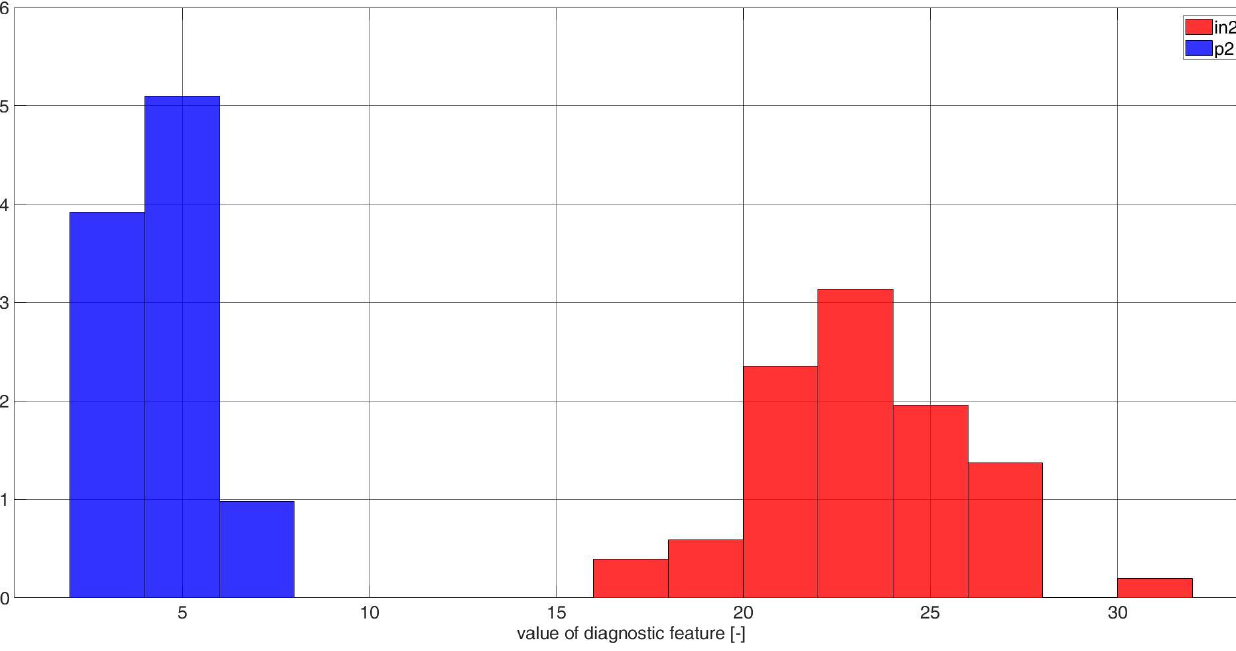
Figure A12. Histograms of diagnostic features based on the CCSM3 (correlation number is 12—Table A1) bearings in2 and p2.